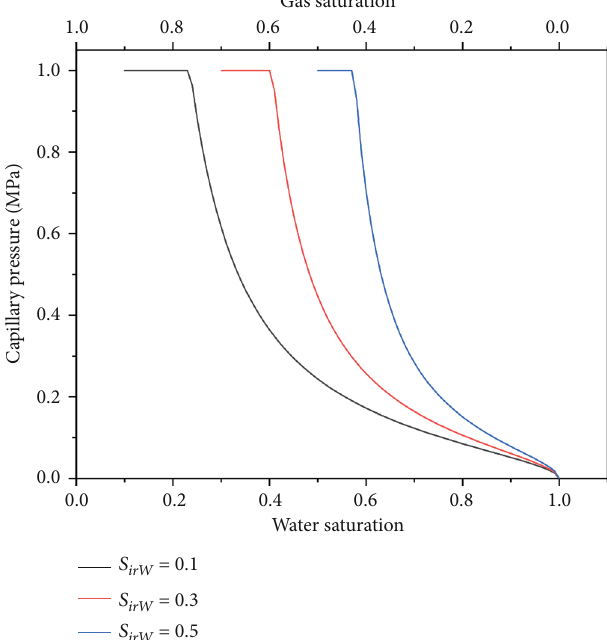
Figure 7: Relationship between capillary pressure and water or gas saturation in di ff erent irreducible water saturation